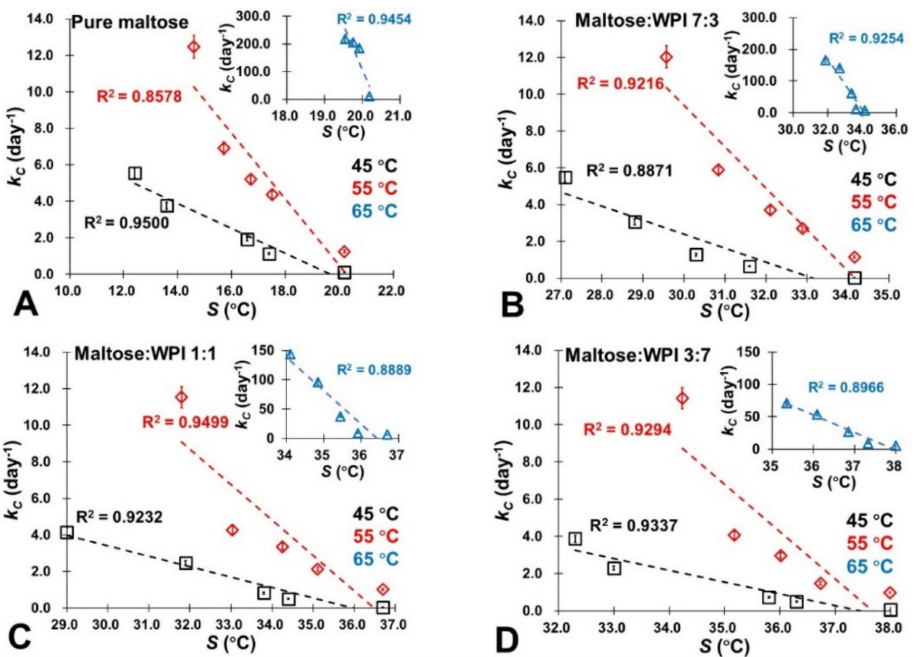
Figure 6. The relationship between the rate of color changes ( k C ) of the studied samples based on colorimetric measurement and their corresponding S values calculated based on the literature [23].